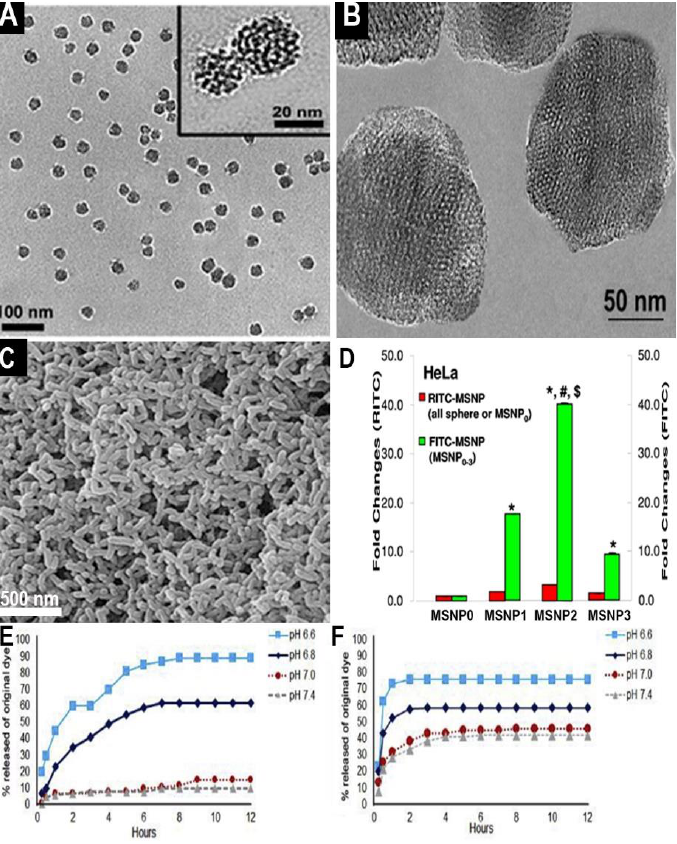
Figure 3. Shape and porosity differences between MSNs influence outcomes. ( A ) Wormhole pore MSNs with a particle diameter of 25 nm and a pore diameter of 1.3 nm, reprinted with permission from [38] , Elsevier, 2018. ( B ) Honeycomb pore MSNs with a particle diameter of 130 nm. ( C ) Rod- shaped MSNs synthesized from TEOS, reprinted with permission from [60] , Elsevier, 2020. ( D ) MSN rods of AR ≈ 2.1–2.5 (MSNP2) exhibited high uptake in HeLa cells, according to the RITC and FITC analysis, as compared to spheres (MSNP0) and rods of smaller (MSNP1) and larger (MSNP3) AR values; * indicates p < 0..05 when compared with MSNP0; # indicates p <0.05 when compared with MSNP1; $ indicates p < 0.05 when compared with MSNP3. Reprinted with permis- sion from [53] , ACS Publications, 2011. ( E ) Wormhole porous MSNs with chitosan gatekeeper networks exhibit more favorable pH-specific controlled release compared to ( F ) honeycomb po- rous MSNs with the same gatekeeper. ( A,B , E,F ) reprinted with permission from [38] , Elsevier, 2018.